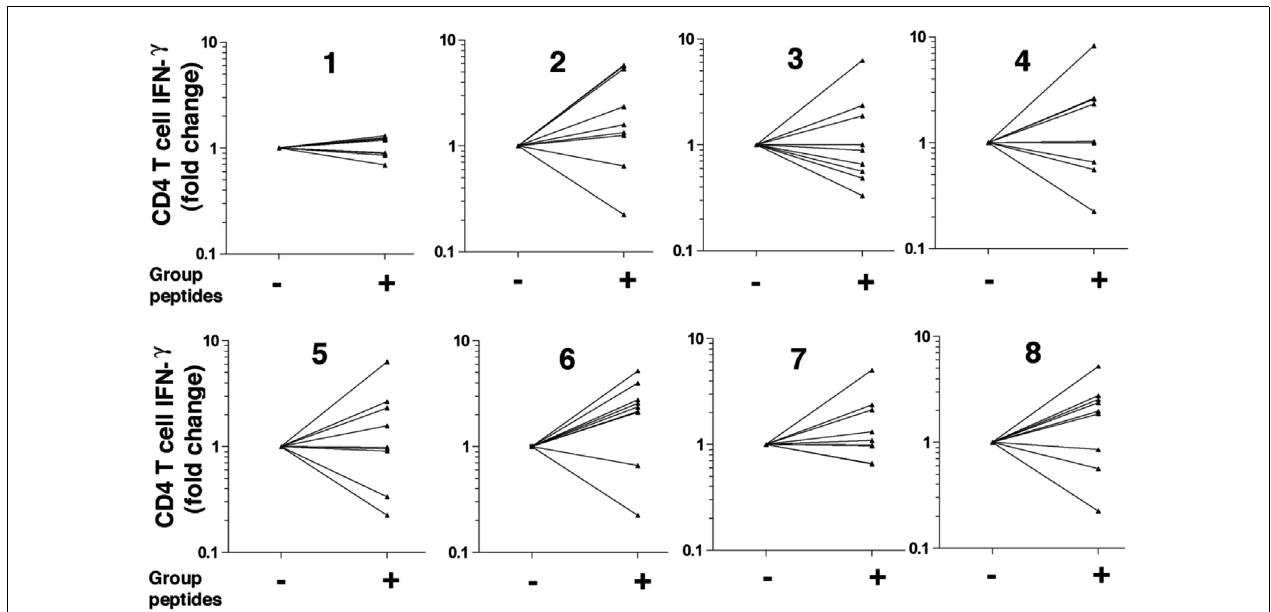
isolated in control ever-smokers without emphysema in the presence or absence of 20-mers (300 µ g/ml) in each group. Fold increase over nil stimulation in secreted IFN- γ are shown in 2 combined groups per spray plot; n = 9. Numbers on top of each spray plot represents the specific pooled group as described in FigureA4 in Appendix).